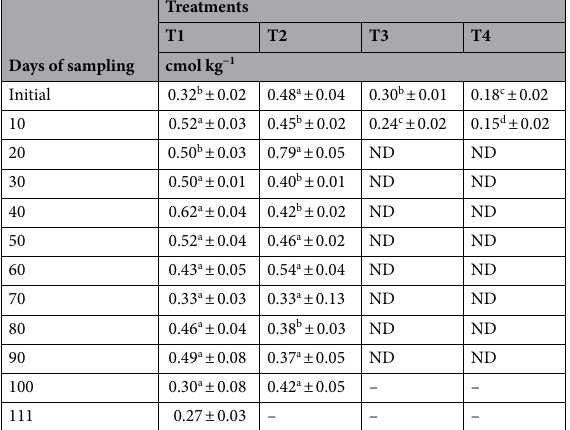
Table 9. Chicken litter biochar on exchangeable Al 3+ at one hundred and eleven days after transplanting of MR219. Different letters within a row indicates significant difference between means of four replicates ± standard error using Tukey’s test at p ≤ 0.05. ND = Not detected.